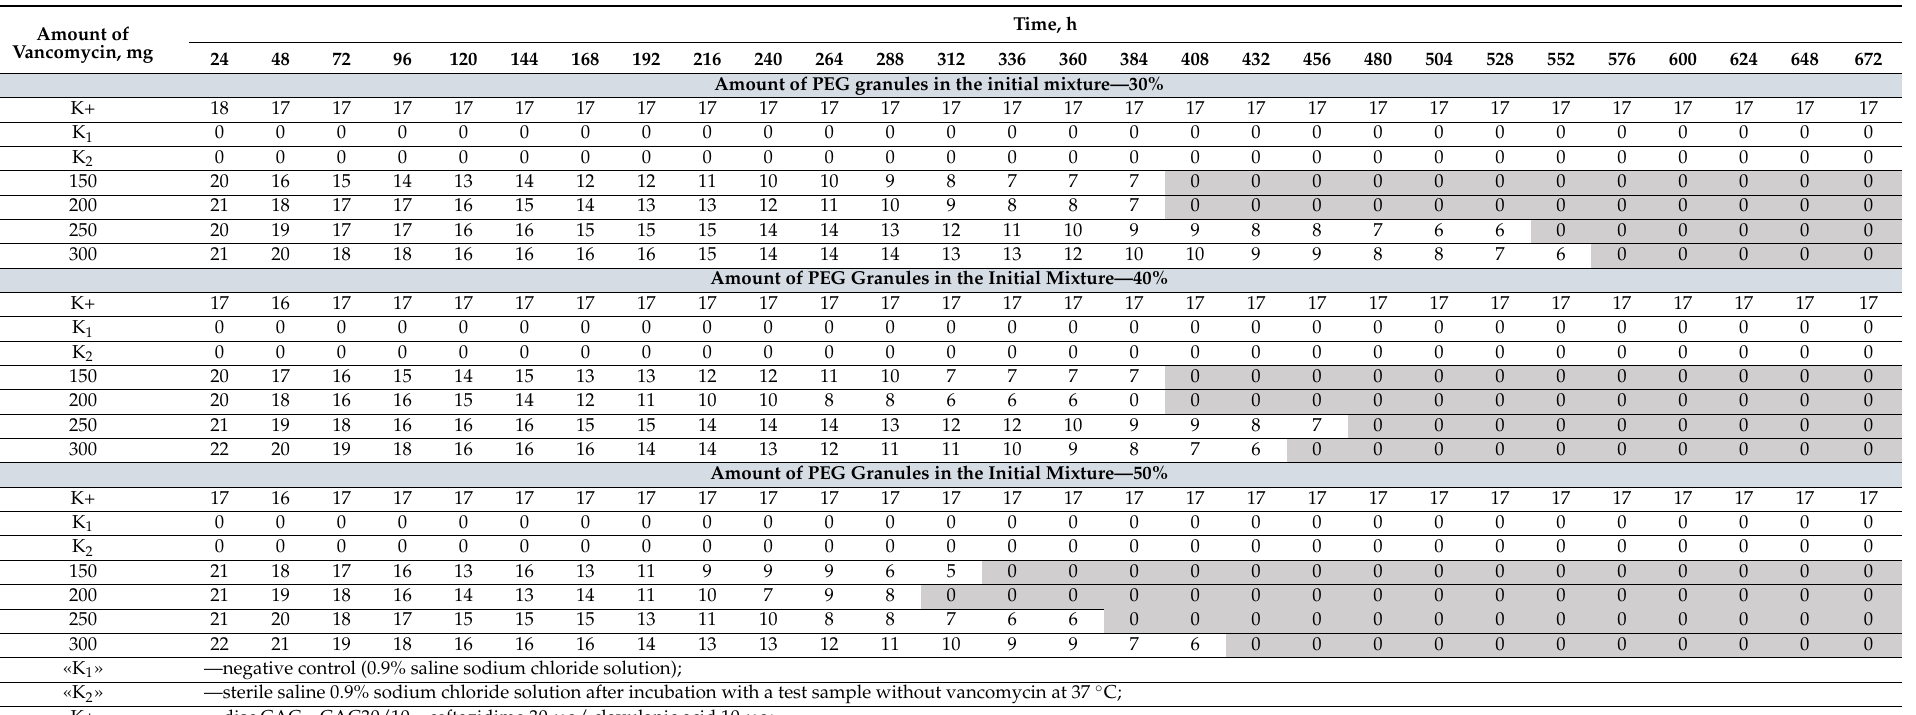
Table 3. Diameters of growth retardation zones of bacterial cultures of Escherichia coli with chemically bonded ceramics containing vancomycin, in comparison with negative and positive